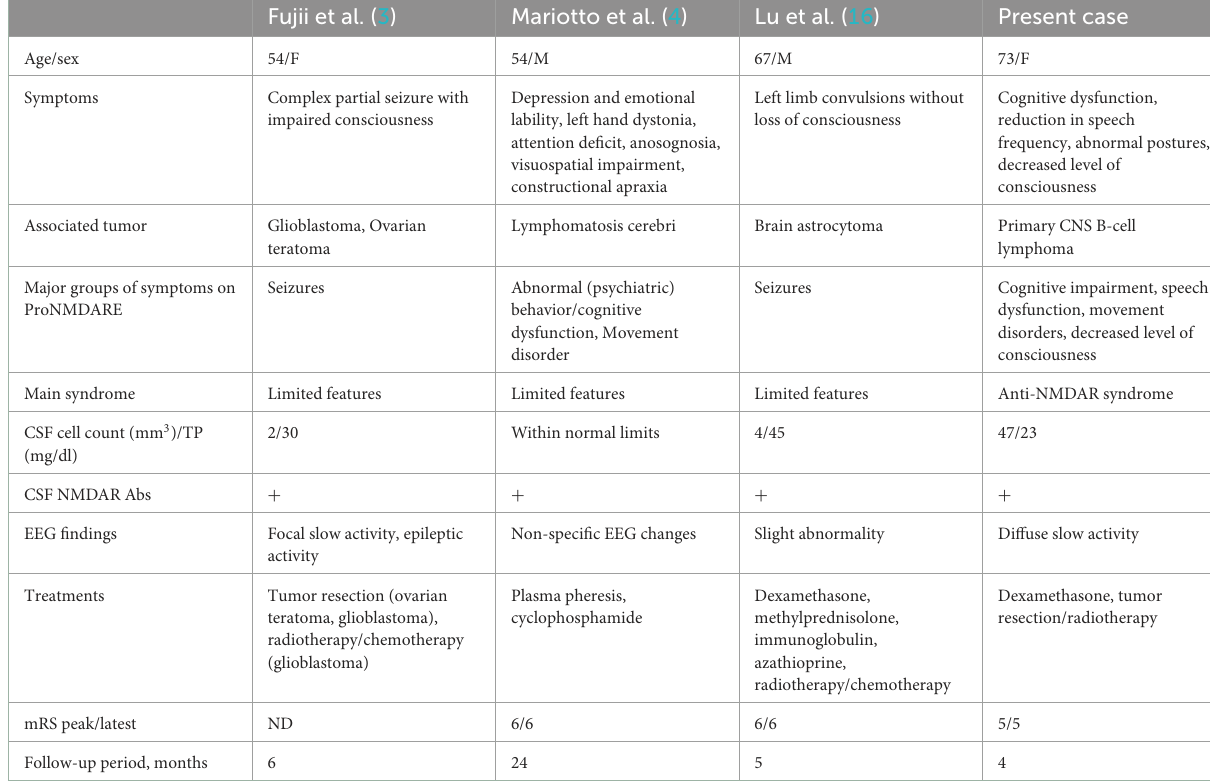
TABLE 1 Literature review of brain tumors concomitant with anti-NMDAR